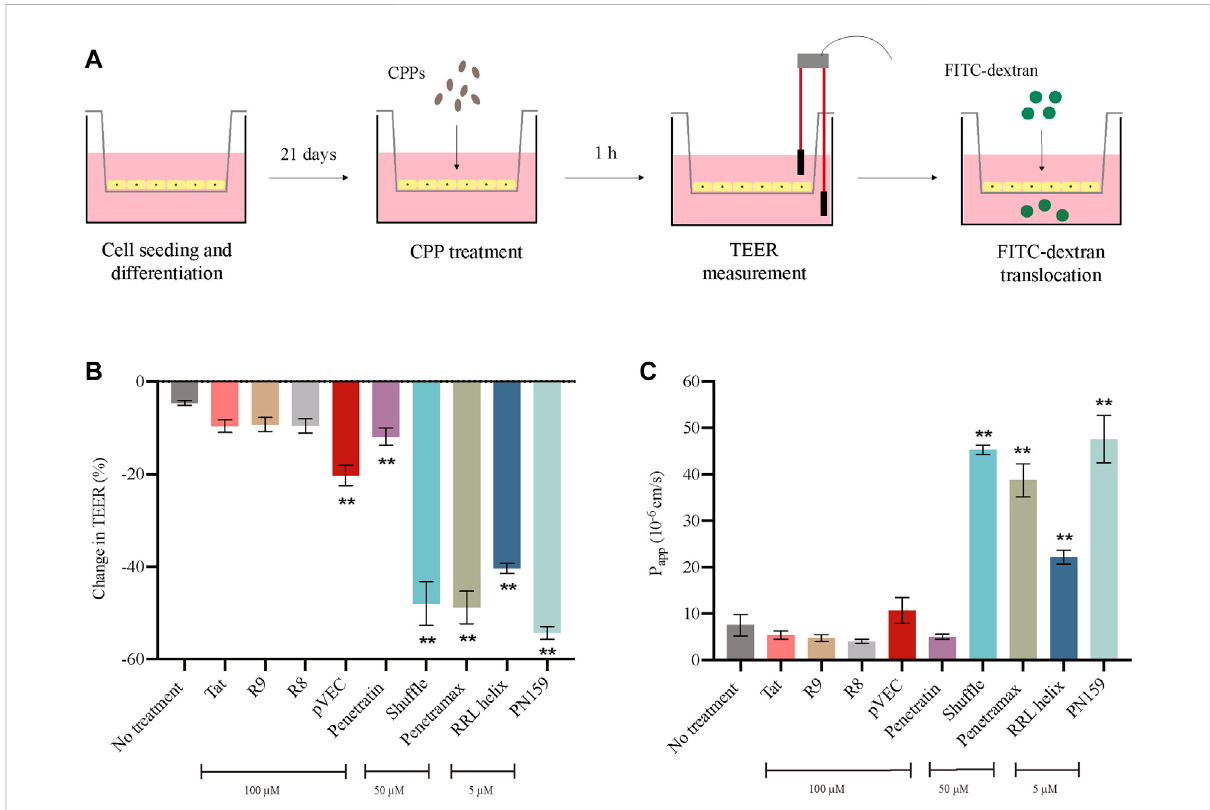
FIGURE 2 Effect of CPPs on barrier integrity of intestinal epithelial cells. (A) Pictorial representation of TEER and FITC-dextran translocation assays. (B) Change in TEER values after 1 h treatment with CPPs. (C) Permeability of FITC-dextran (Papp A-B 10 ^ -6 cm/s) after 1 h treatment with CPPs. Values are presented as means ± SD, n = 3. Statistical analysis: Analysis of variance (ANOVA) followed by Dunnett ’ s multiple comparisons test, p < 0.01 as compared to the control group (no treatment).